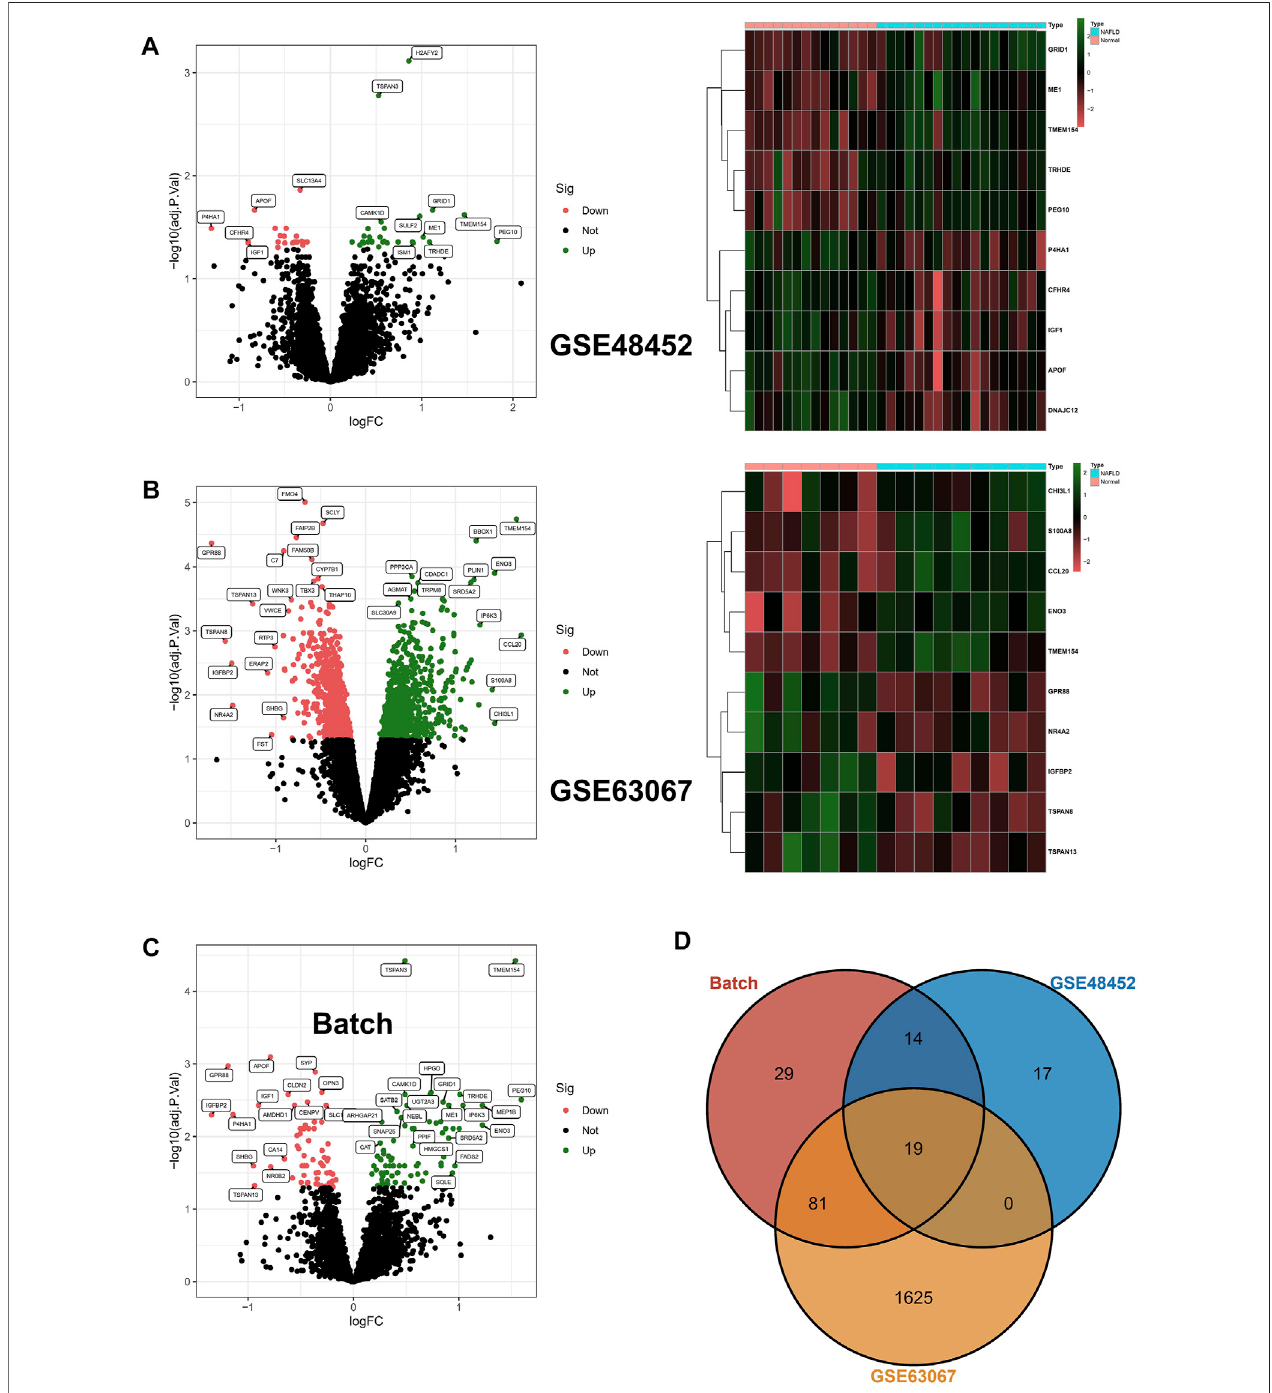
FIGURE 1 | Differentially expressed genes. (A,B) Differentially expressed genes (DEGs) were identi fi ed in GSE48452 and GSE63067, respectively, with upregulated genes indicated in red and downregulated genes ingreenin the volcano plot; in addition, theheat map shows the top 10differentially expressed genes. (C) After batch correction, we again identi fi ed DEGs in the screening set using the limma package, and the volcano plot in red indicates upregulated genes and green indicates downregulated genes. (D) The DEGs from the three aforementioned screens were crossed, resulting in the identi fi cation of 19 core DEGs.